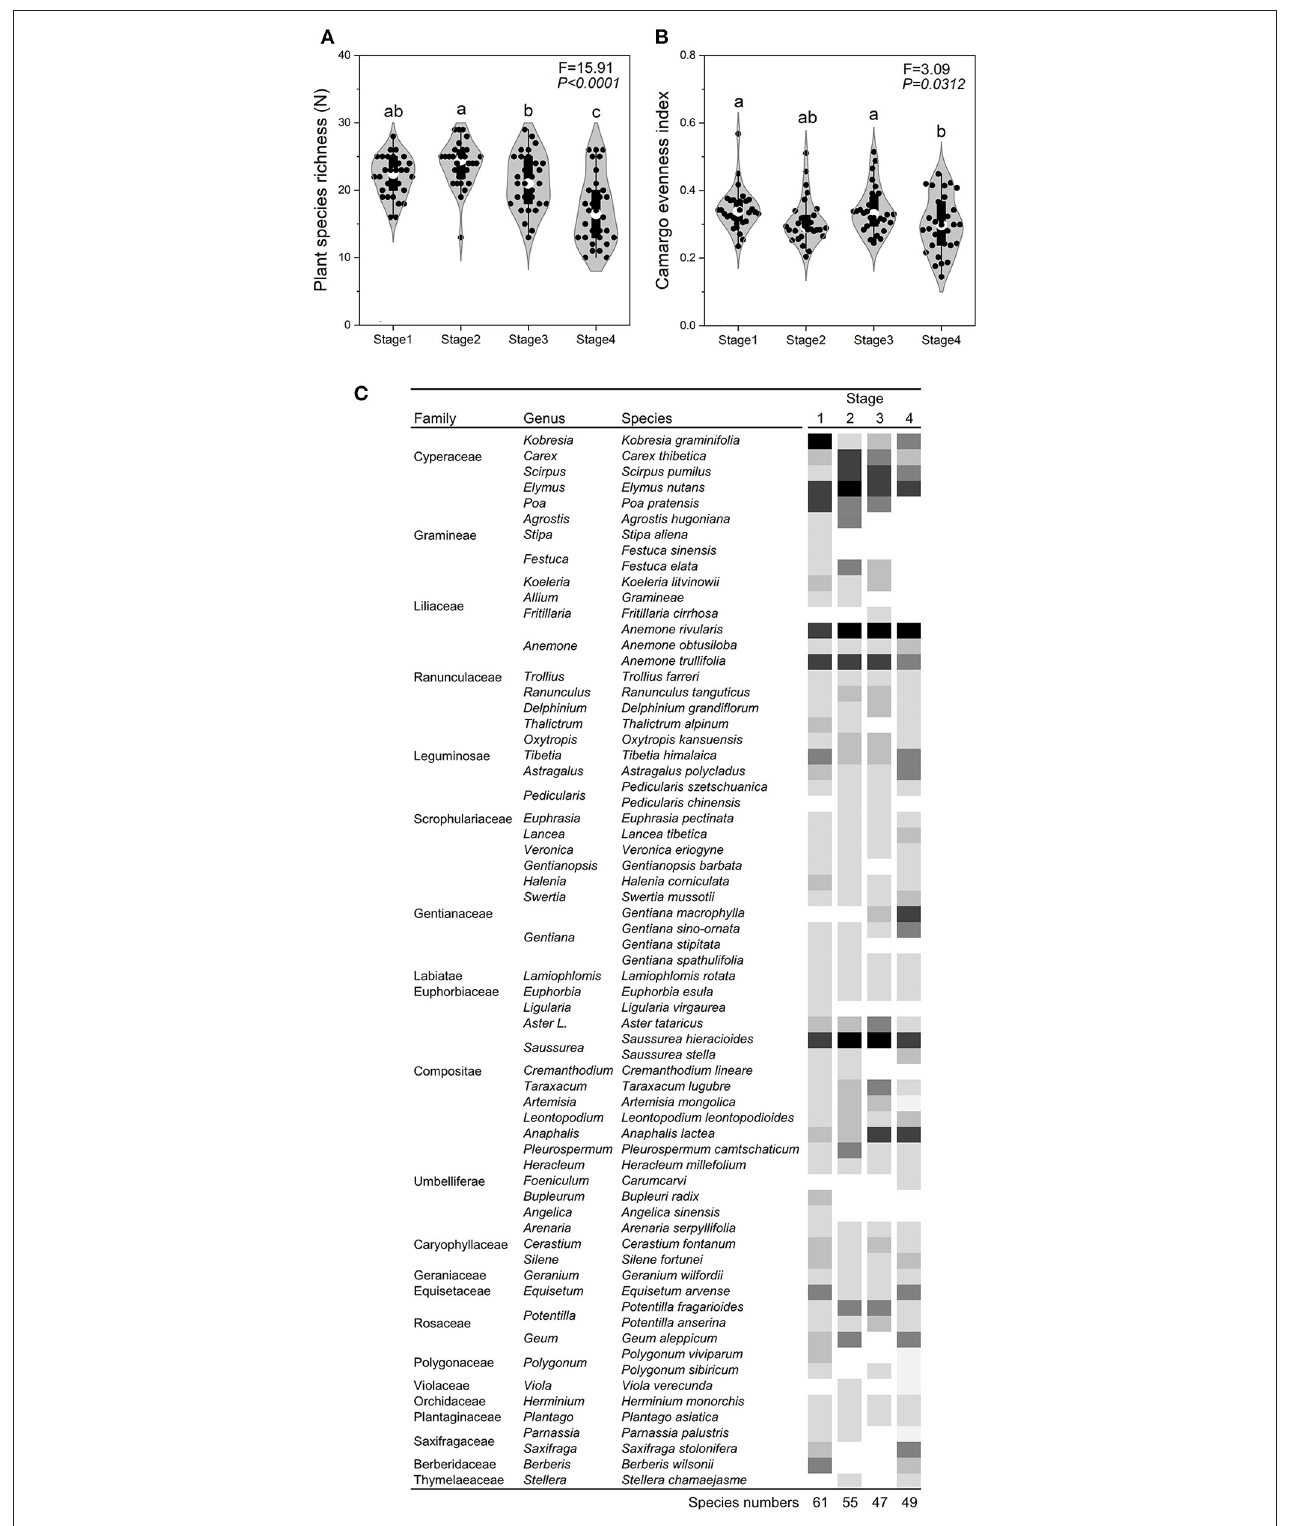
FIGURE 2 | Changes characteristics across the four stages of succession. Plant species richness (A) , Camargo evenness index (B) , and plant composition (C) across the successional stages. In Stage 1, the dominant plant species were Kobresia graminifolia , Elymus nutans , Poa pratensis , Anemone rivularis ,